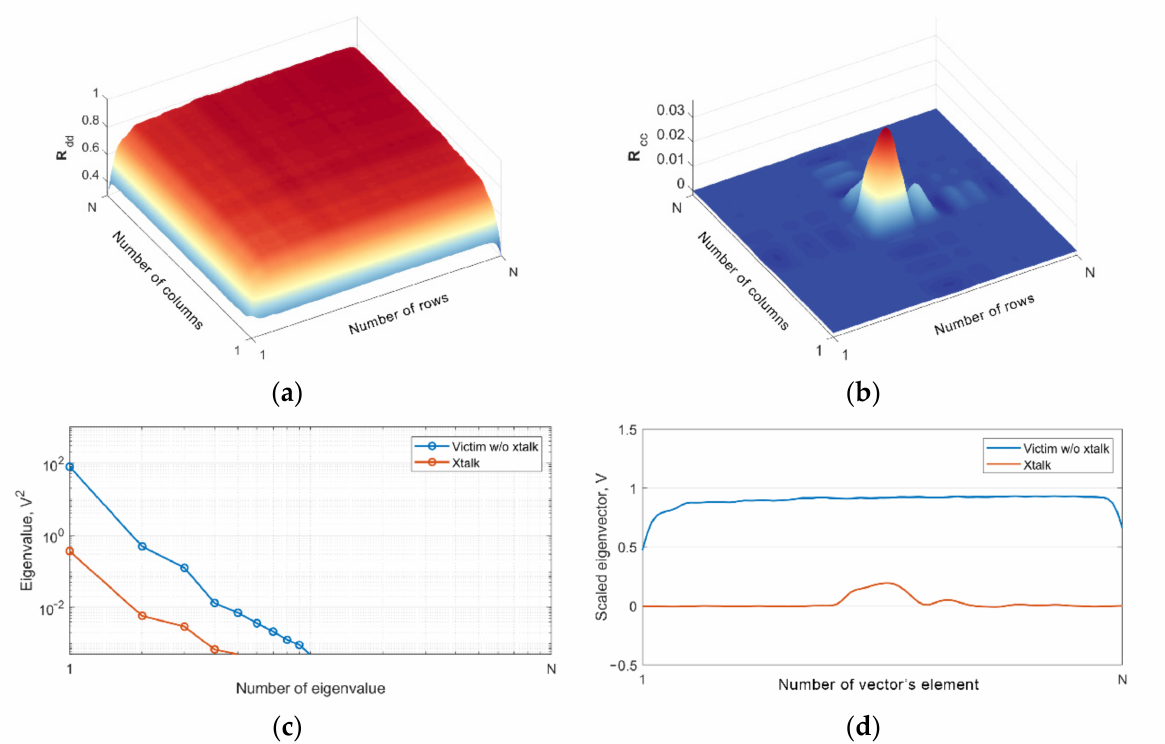
Figure 10. ( a ) The correlation matrix R dd of the victim signal without crosstalk; ( b ) the correlation matrix R cc of the crosstalk interference signal. ( c ) The eigenvalues of the correlation matrices R dd and R cc . ( d ) The scaled eigenvectors of the correlation matrices. Bit rate is 0.4